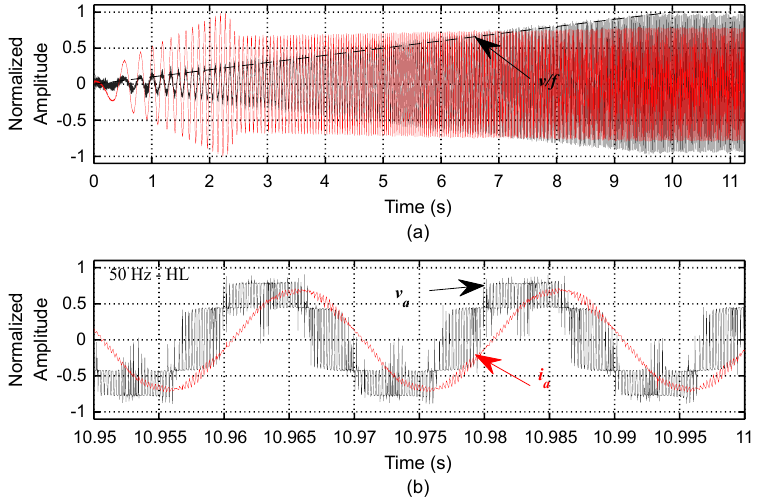
Figure 5. Voltage ( v a ) and current ( i a ) waveforms in the induction motor fed by the voltage source inverter during: ( a ) 10 s of startup transient and 1 s of steady state, and ( b ) close up of the steady state.